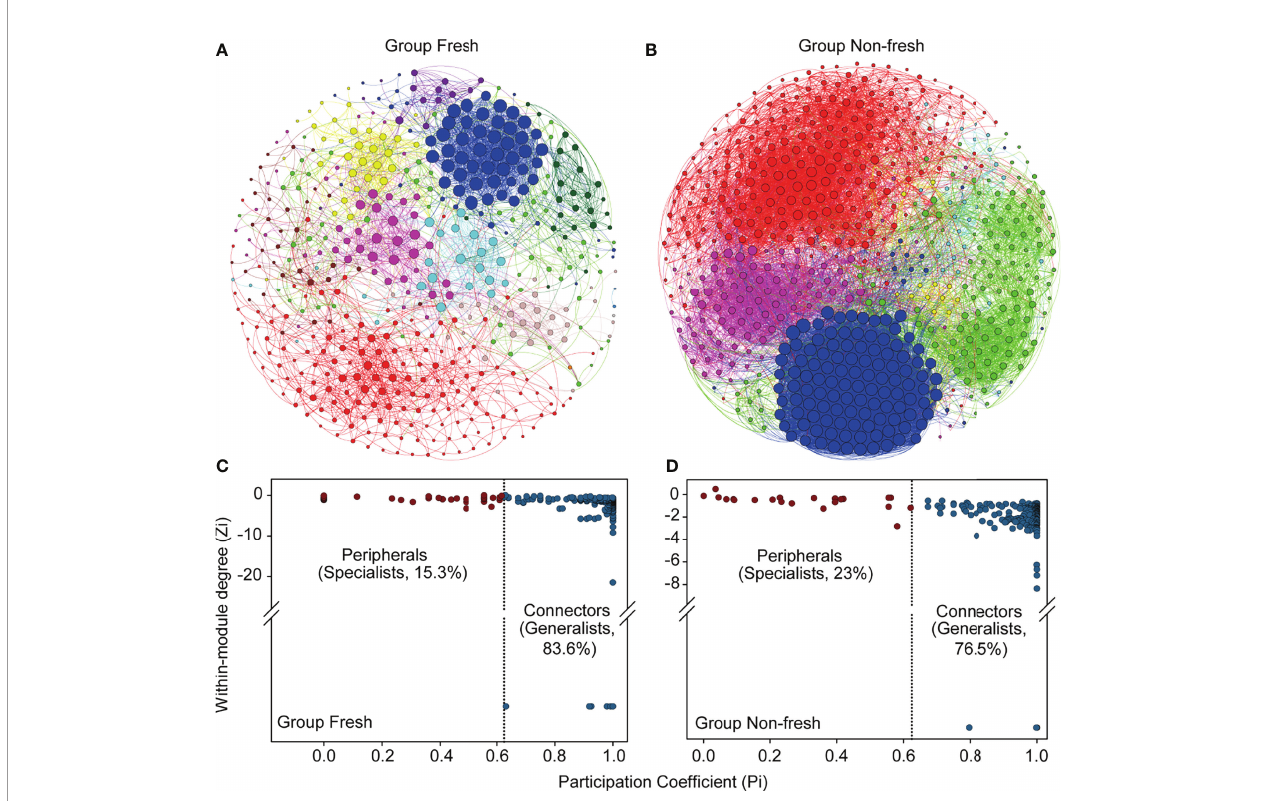
FIGURE 7 | Bacterial co-occurrence networks of Group Fresh (A) and Group Non-fresh (B) . Each node represents a genus, with larger size indicating higher degree. Edges were colored as their source nodes. Only Spearman ’ s rank correlations |r| > 0.6 and corresponding p < 0.05 are shown as edges. In each network, nodes with same color belong to same module. Between two networks, modules with the same color in two networks did not necessarily mean that they are the same module. Based on participation coef fi cient and within-module degree, topographic roles of nodes are organized into two categories: peripherals (red) and connectors (blue) for Group Fresh (C) and Group Non-fresh (D)